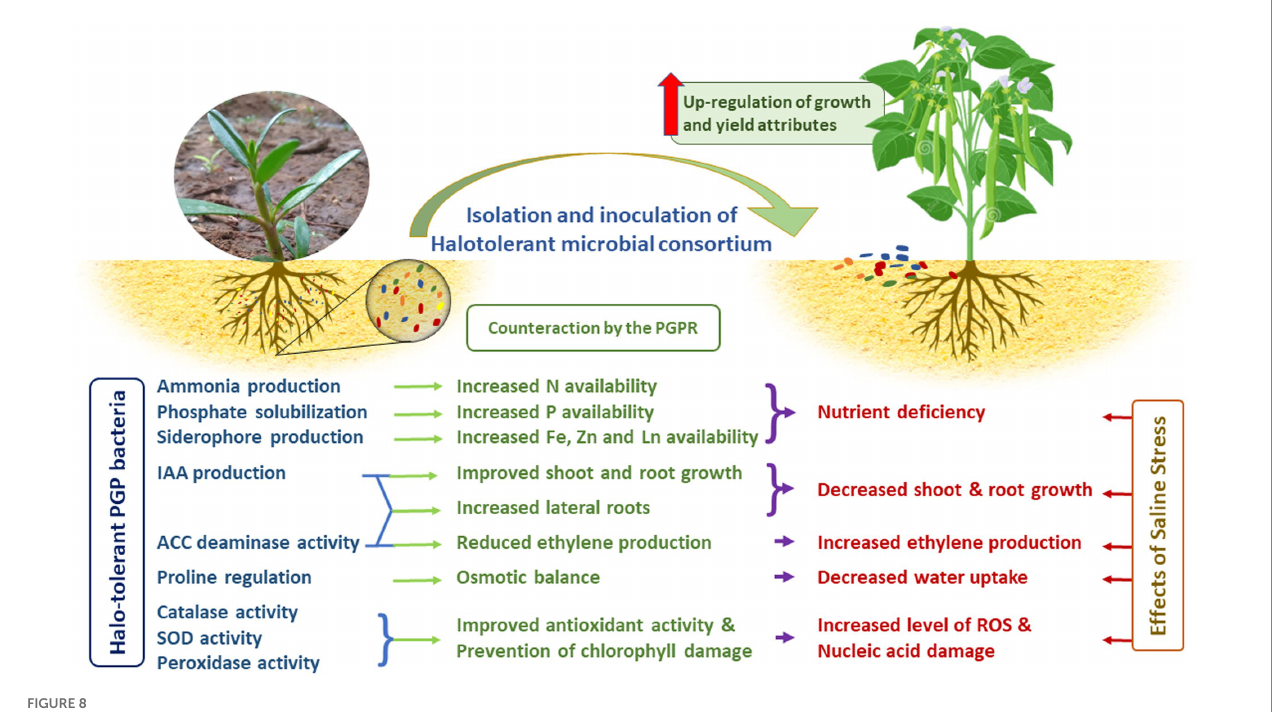
FIGURE 8 Prospects of halotolerant microbial consortia for alleviation of saline